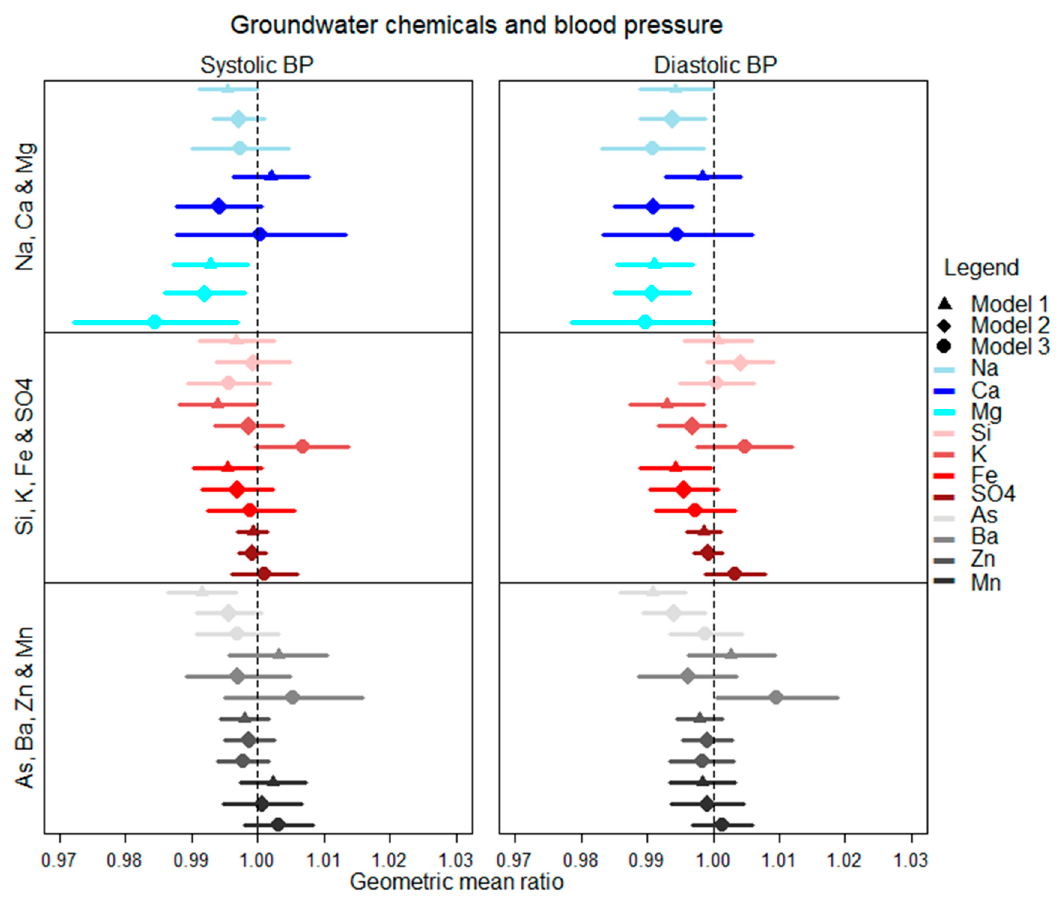
Figure 4. Associations between groundwater chemicals and blood pressure. Associations are shown for one standard deviation increase in water chemicals.